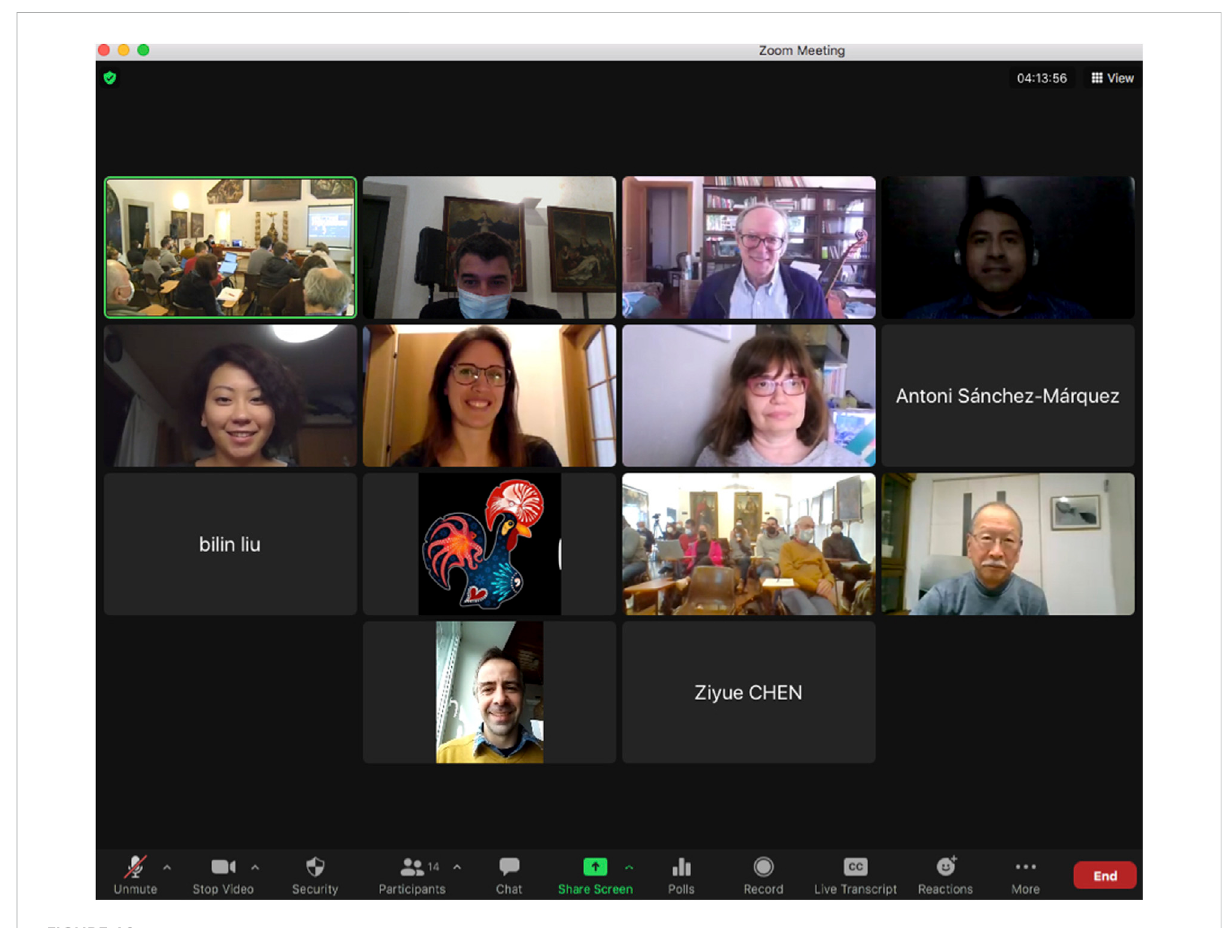
FIGURE A2 Group photo of the participants online of the CIAC 2022 beak workshop (Sesimbra,